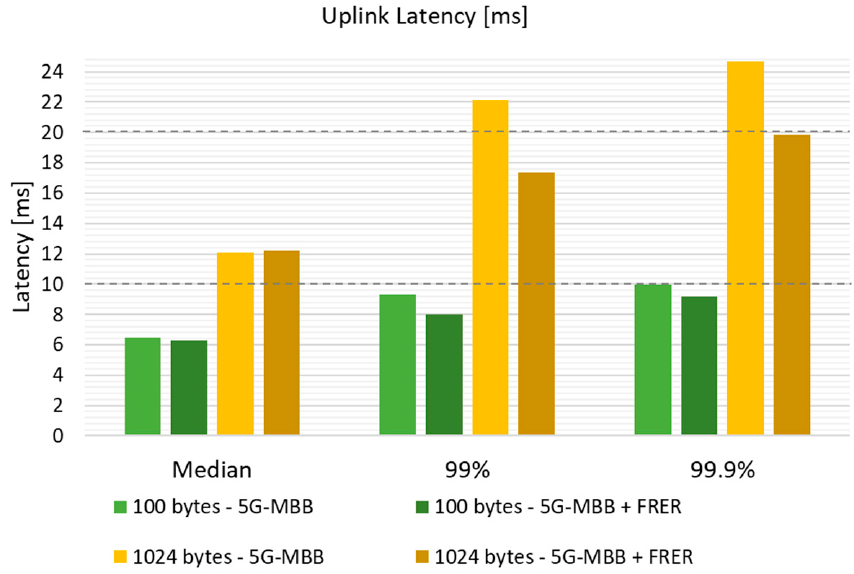
Figure 9. Uplink latency with and without redundant transmissions using FRER.